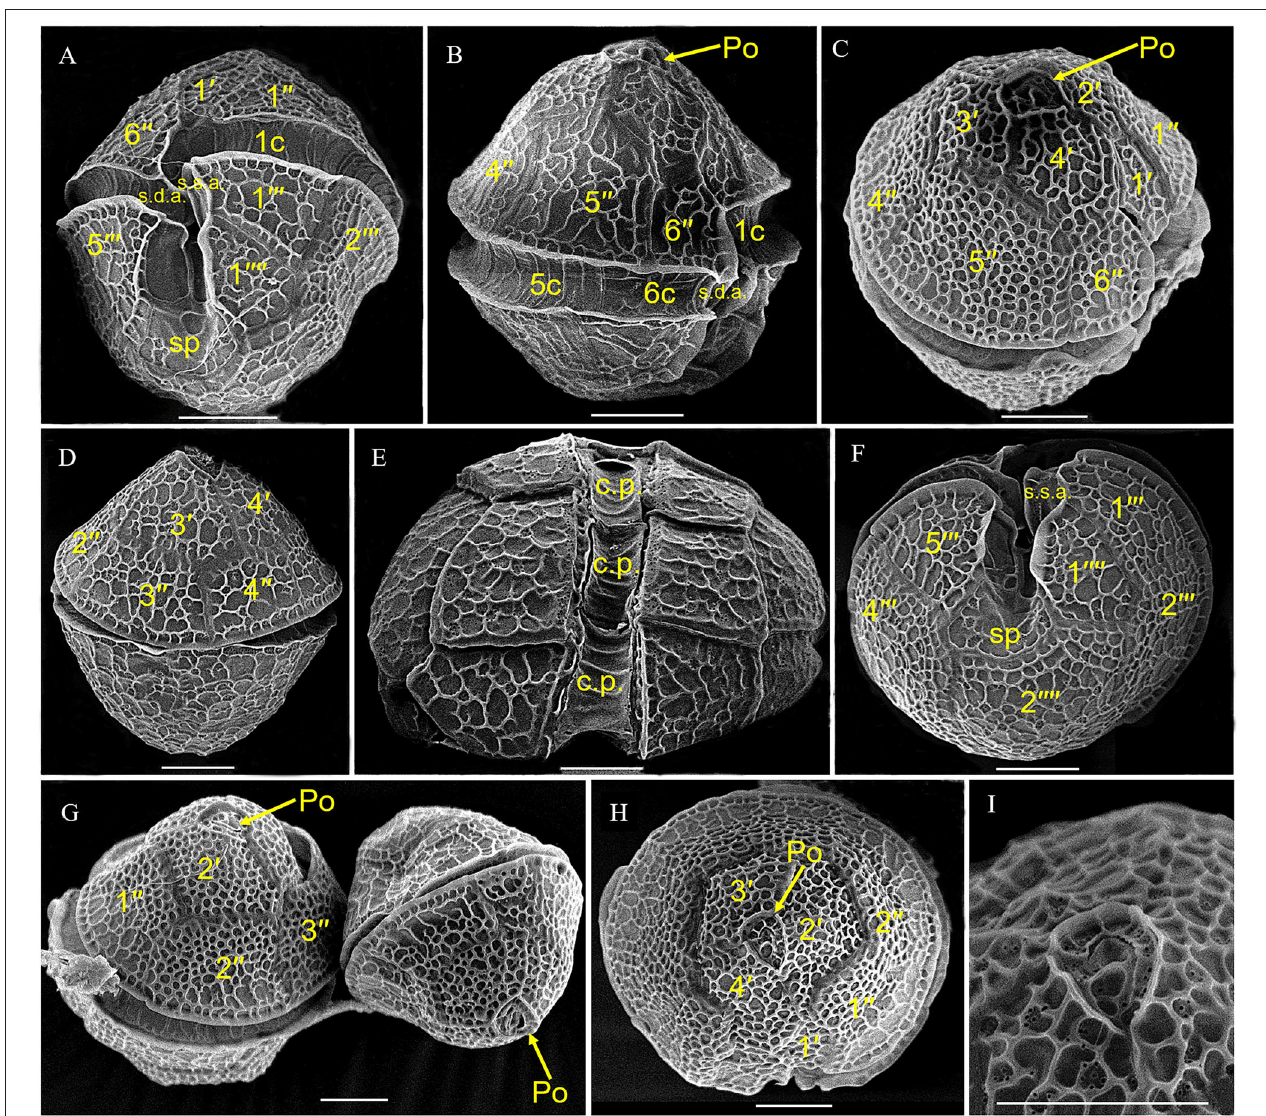
FIGURE 3 | Scanning electron microscopy micrographs of Alexandrium insuetum strain AILYG12. (A,B) Ventral view showing the 1 ′ and sp. (D) Dorsal view. (E) Dorsal view showing the cingular plates (c.p.). (F) Antapical view showing the sp. (C,G,H) Apical view showing the epitheca. (I) Detail of the apical pore complex. s.d.a., right anterior sulcal plate; s.s.a., left anterior sulcal plate; sp, posterior sulcal plate; Po, apical pore plate; c.p., cingular